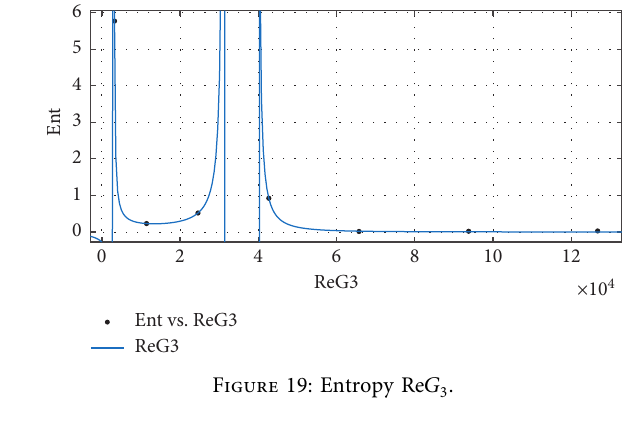
Figure 19: Entropy Re G